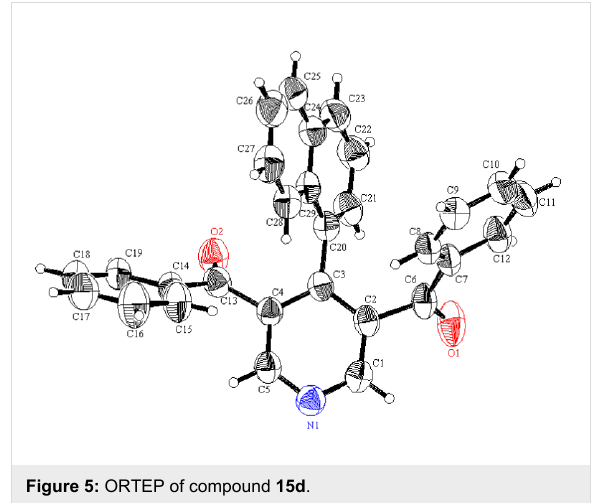
Figure 5: ORTEP of compound 15d